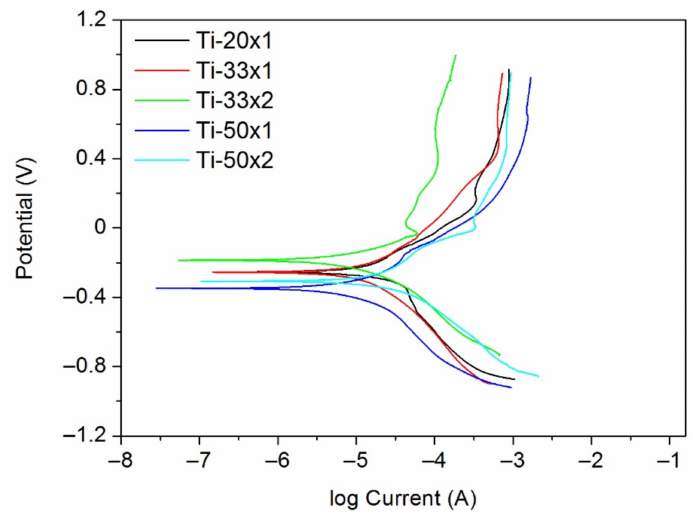
Figure 12. Tafel tests after one hour of immersion in 3.5%